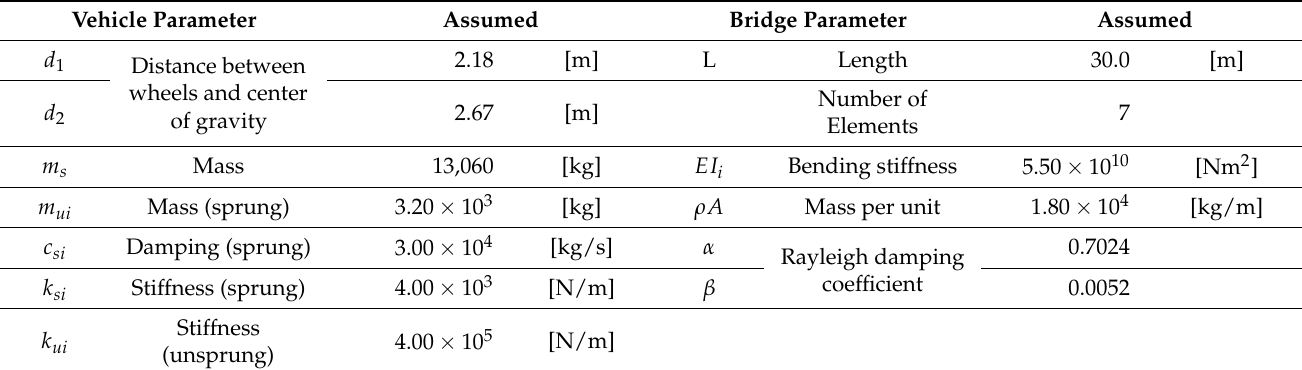
Table 2. The assumed mechanical parameters of vehicle and bridge.